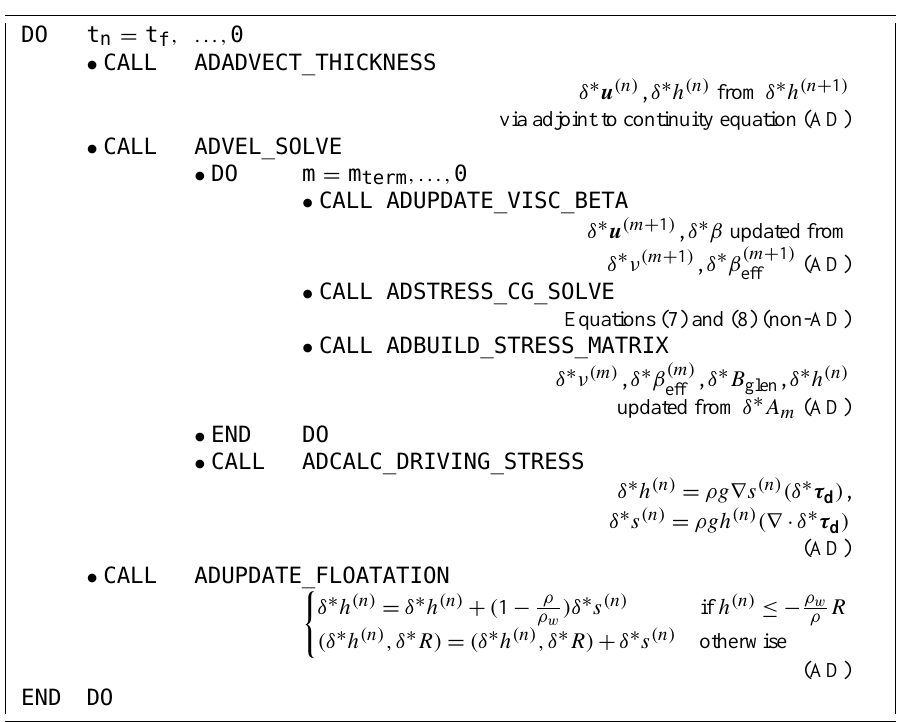
Table 3. Pseudocode version of adjoint model reverse-time-stepping algorithm corresponding to Table 1. (AD) indicates that this step is processed by the algorithmic differentiation